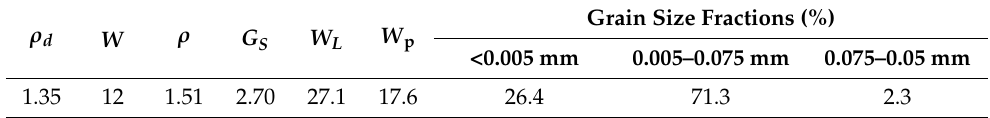
Figure 3. Physical properties of loess specimens showing: ( a ) grain-size distribution curve; ( b ) Casagrande plasticity chart. Table 1. Basic physical indexes of loess.